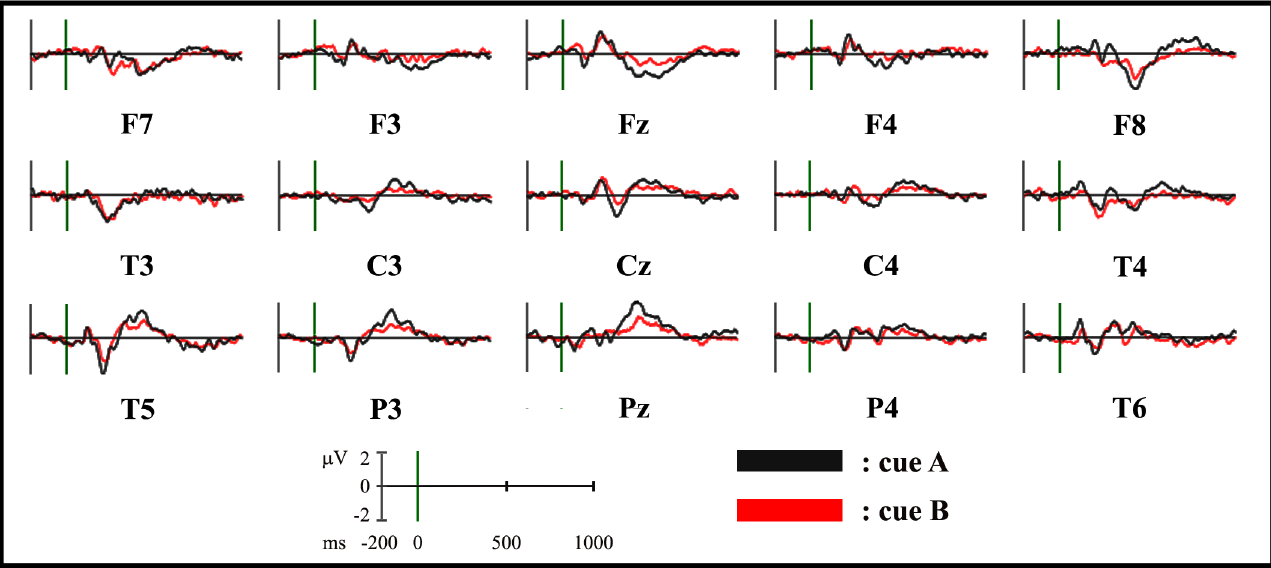
Fig 3. ERP waveforms for the cues in the two experimental sessions at selected electrodes. Group-averaged (n = 15) cue-locked ERP waveforms, plotted as voltage in μ V in function of time in ms (stimulus onset: 0 ms). Black: session A cue; red: session B